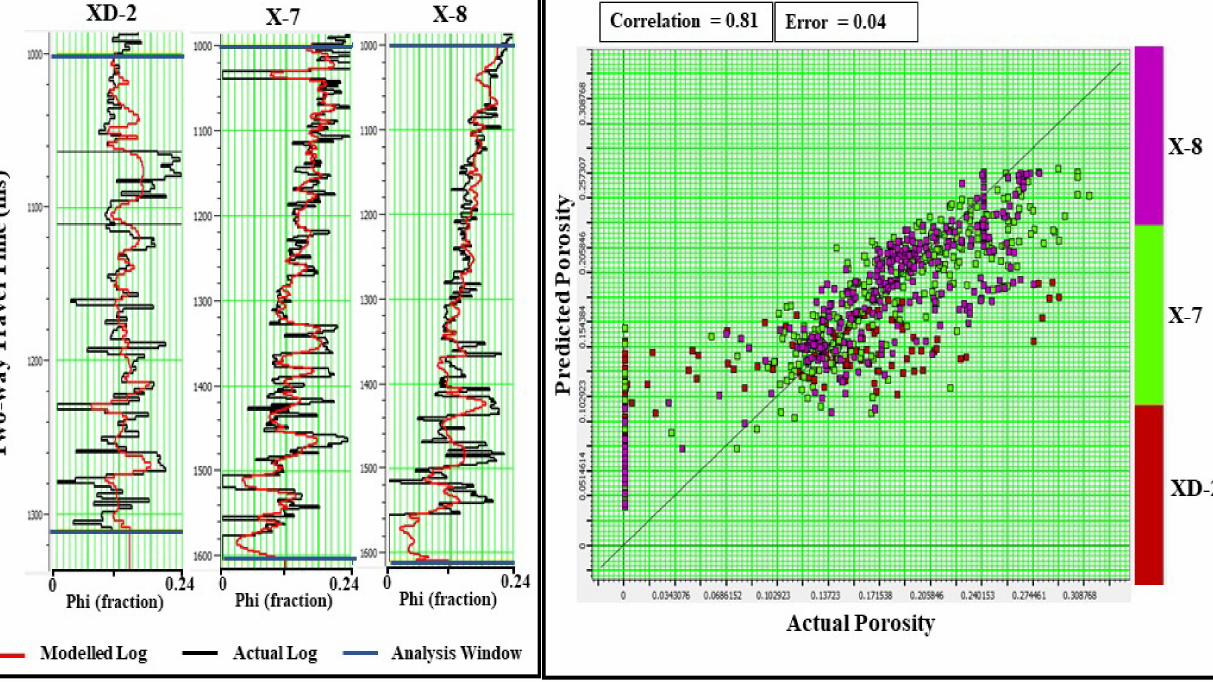
Figure 24. The error analysis window for ANN validation demonstrates a 0.04 validation error and 0.81 correlation between the true and estimated porosity. The trained-porosity from ANN demonstrates a 0.03 training error and a 0.83